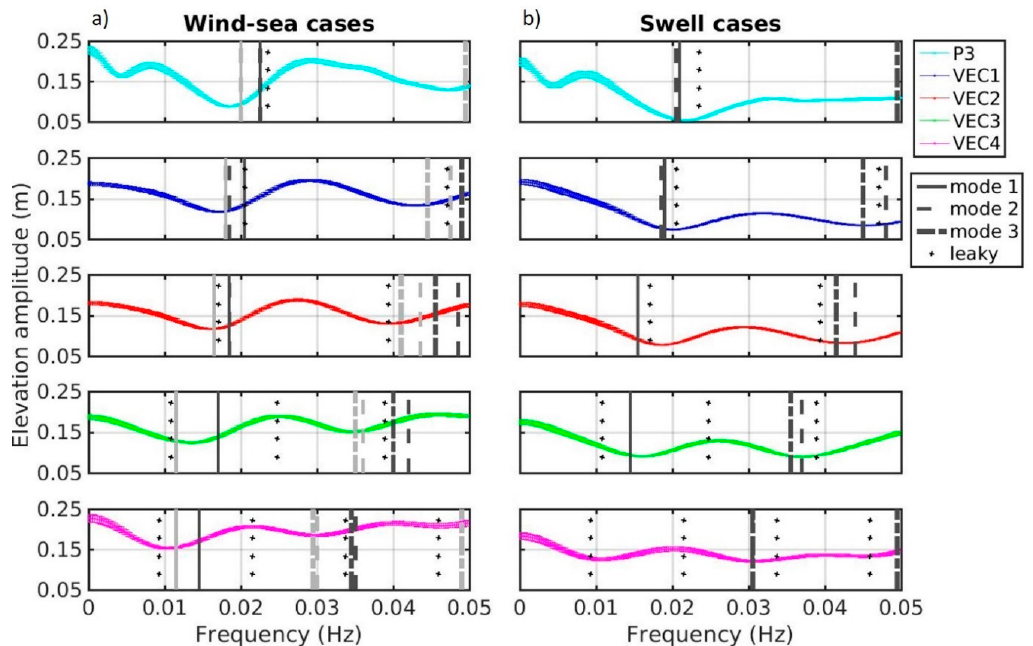
Figure 6. Elevation amplitude versus frequency, averaged over ( a ) wind-sea cases (between 4 pm and 7 pm), ( b ) swell cases (between 7 am and 10 am), at five locations along the cross-shore array. Coloured lines are the measurements. The width of the lines represents the error (standard deviation). Vertical lines represent the theoretical frequency of nodes in elevation for three edge wave modes: n = 0 (black solid lines), n = 1 (black dashed lines), n = 2 (black dash-dot lines) and standing leaky waves (gray solid lines). For case a), both nodes for both northward (dark gray) and southward (light gray) propagating edge waves are represented.